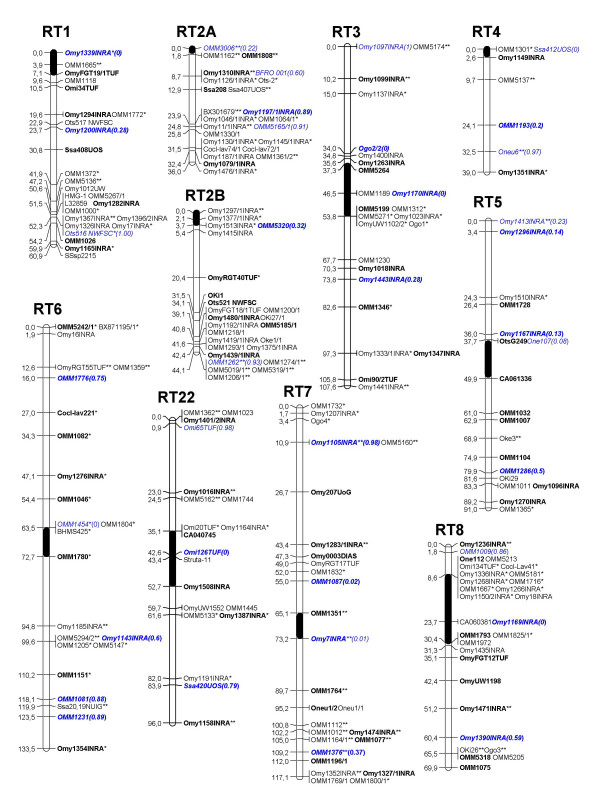
Graphic representation of linkage groups RT1 to RT9. Groups are numbered as in Nichols et al. (2003). Map distances are given in centiMorgan using recombination percentage between loci. Loci with names in blue italic type were used for centromere mapping in the meiogenetic line. Recombination fraction for these loci are given. Putative interval of centromere localisations are materialized by black areas. Loci in bold type are those of the framework map.*: marker informative in INRA1 only; **: marker informative in INRA2 only.